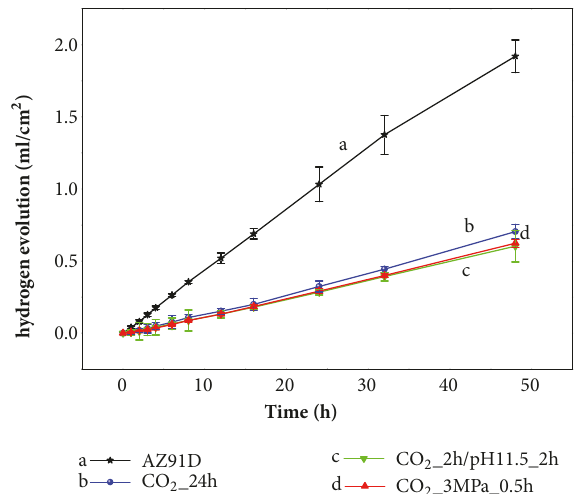
Figure 8: Hydrogen Evolution Curve of the AZ91D alloy with and without conversion coating in 0.6M NaCl